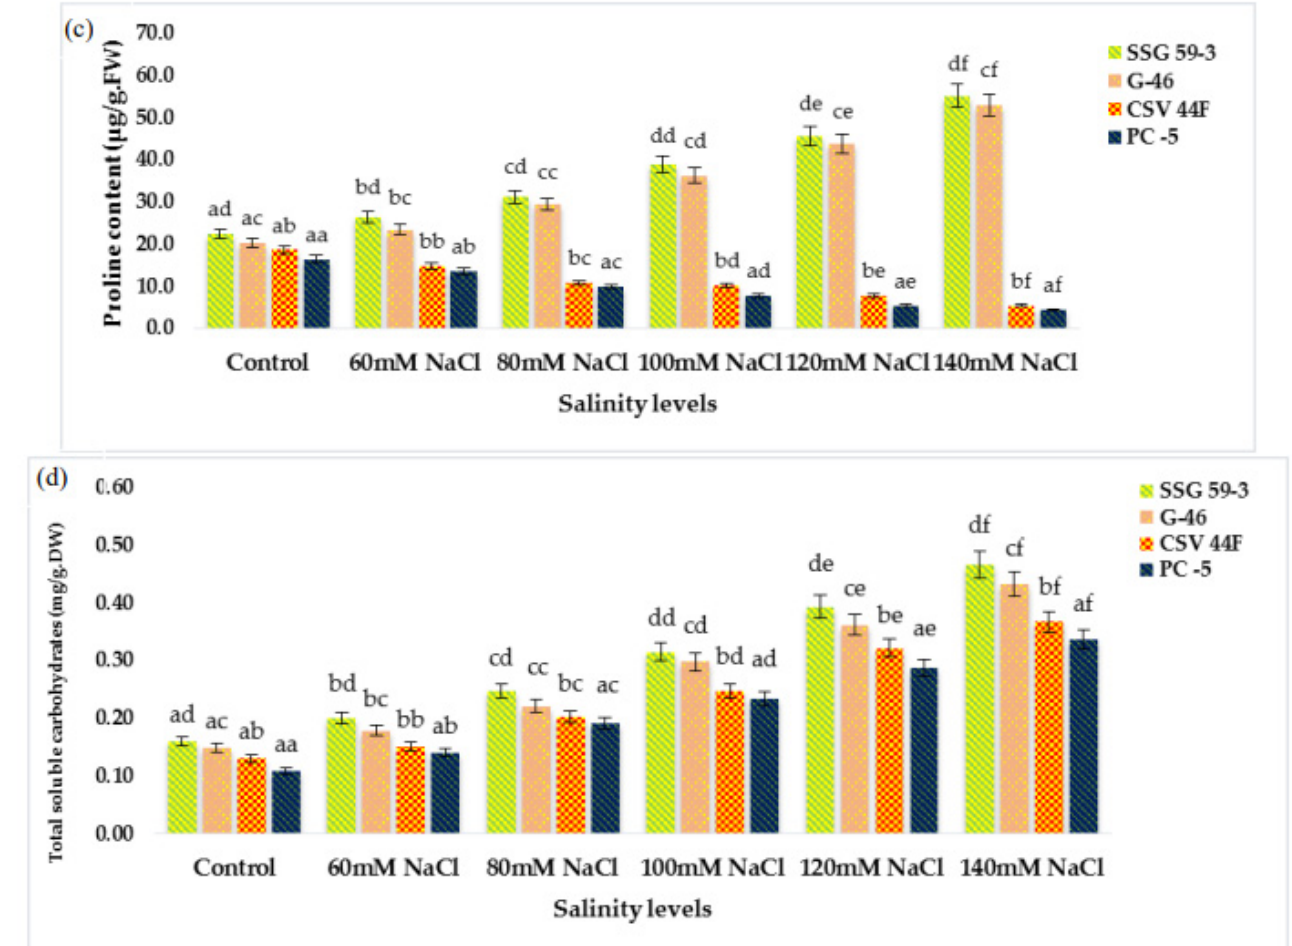
Figure 3. Effect of salinity on ( a ) MDA, ( b ) ascorbic acid, ( c ) proline, and ( d ) total soluble carbohydrates of sorghum seedlings under saline stress. Values represent means ± S.E. a–f Values with different superscripts in the same row are significantly different at p < 0.05.